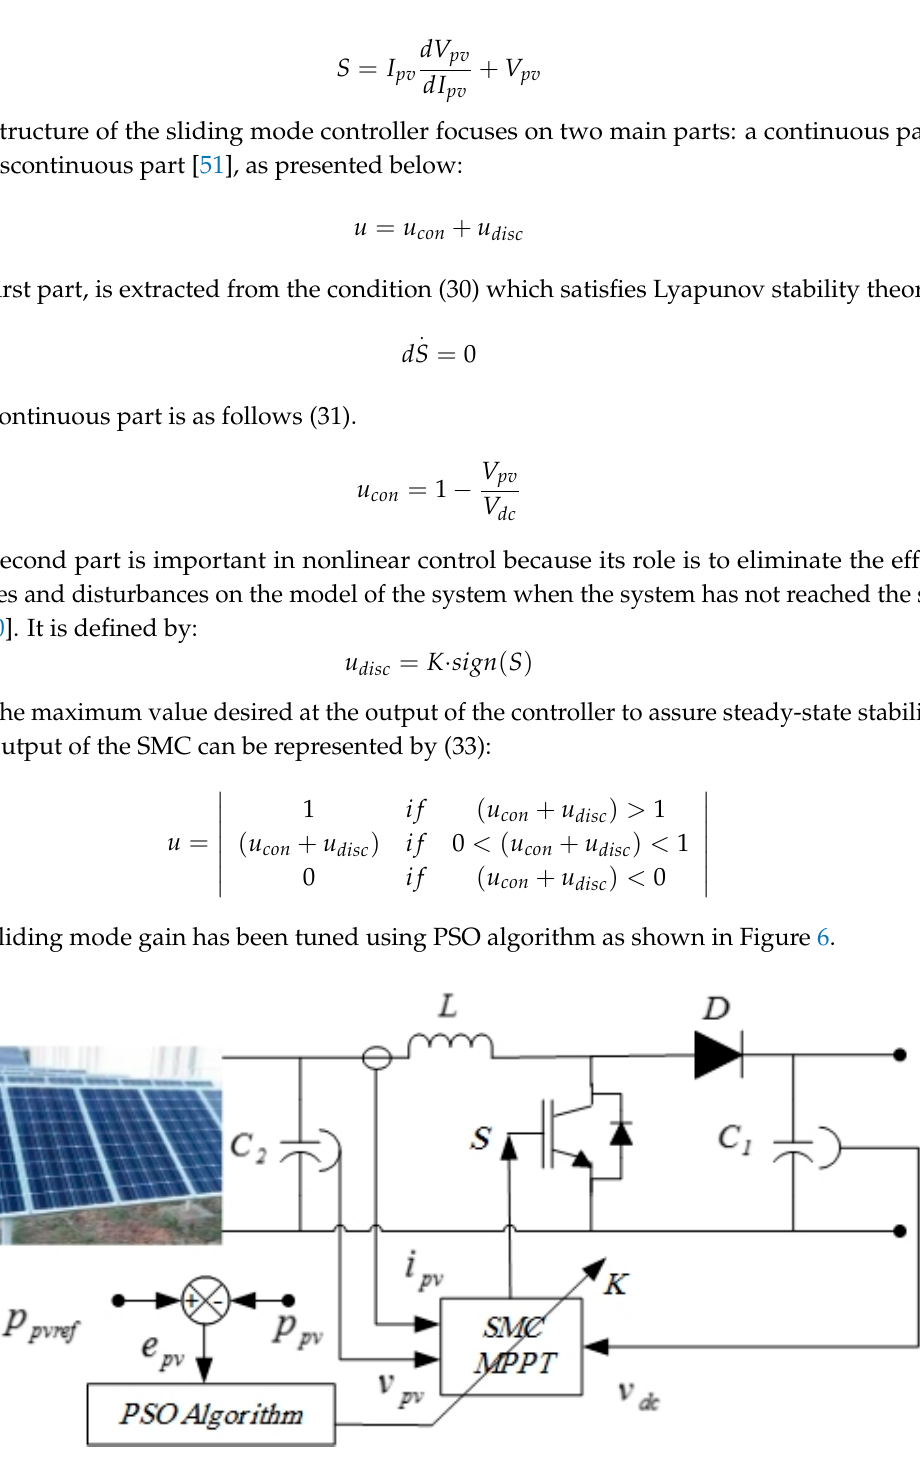
Figure 6. Control of PV system using sliding mode MPPT based PSO.